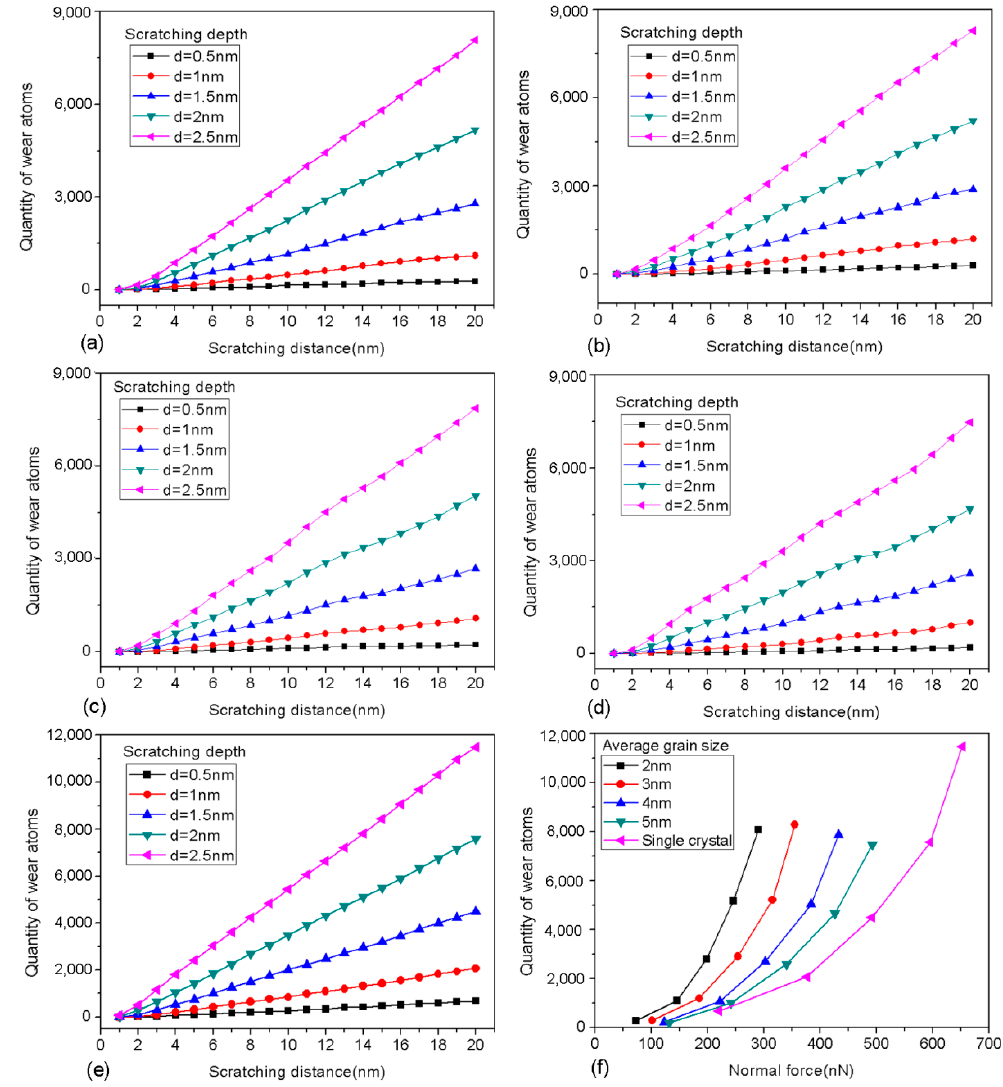
Figure 4. Data plots for the quantity of wear atoms. ( a – d ) The wear relations of polycrystalline silicon substrates with average grain sizes of 2 nm, 3 nm, 4 nm, and 5 nm, respectively. ( e ) The wear relation of single-crystal silicon substrate. ( f ) The quantity of wear atoms as a function of normal load for different silicon substrates.